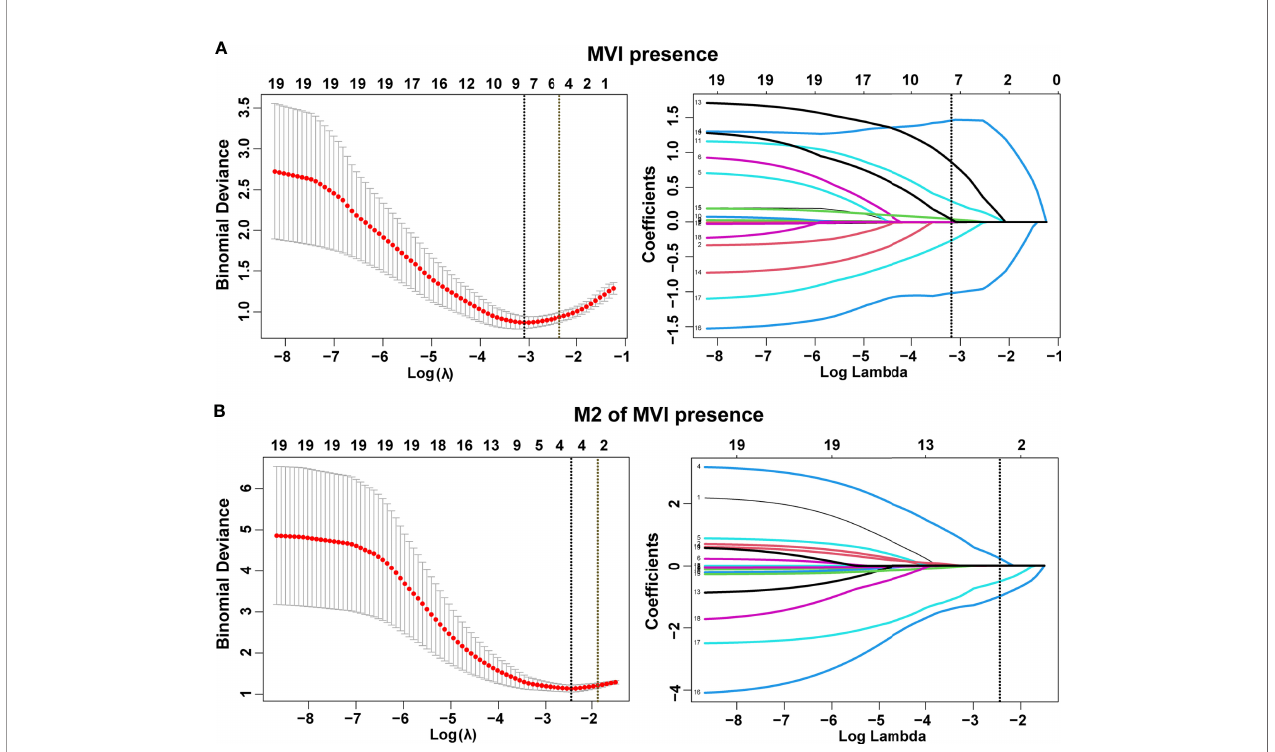
FIGURE 2 | Selection of demographic and clinical features using the least absolute shrinkage and selection operator (LASSO) regression model. Selection of tuning parameter ( l ) in the LASSO model by three-fold cross-validation based on minimum criteria for MVI (A) and its M2 grade (B) . Dotted vertical lines were drawn at the optimal values using the minimum criteria and the 1 standard error of the minimum criteria (1-SE criteria). All features with non-zero coef fi cients are indicated on the right of (A, B)